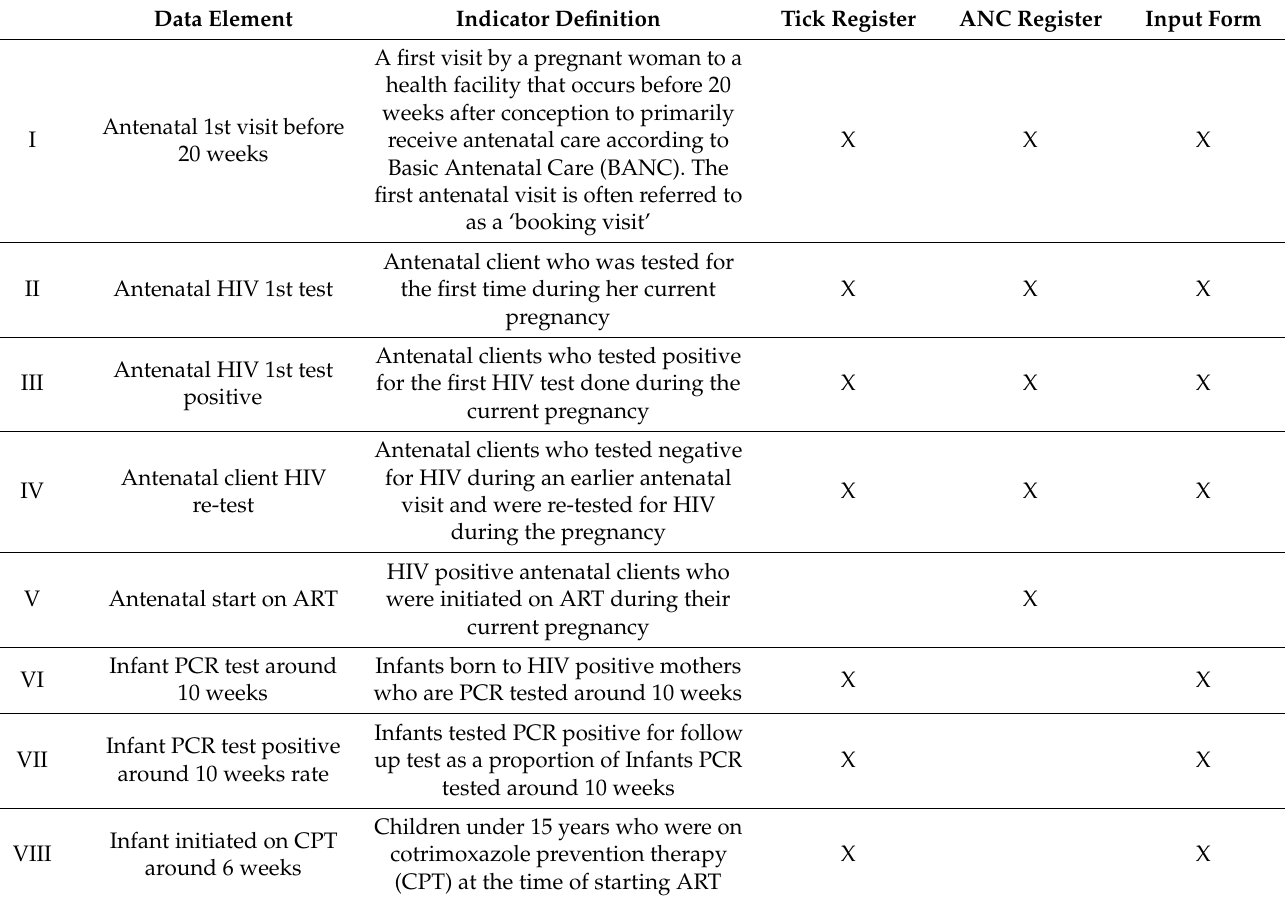
Table 1. Official source documents for selected eight PMTCT data